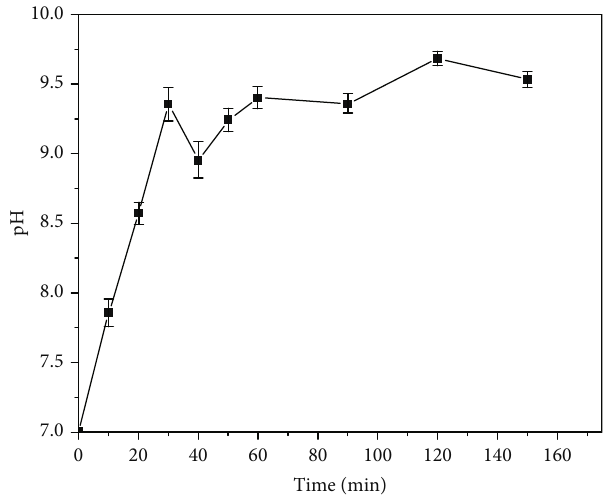
-N removal by ATP-nZVI. 3